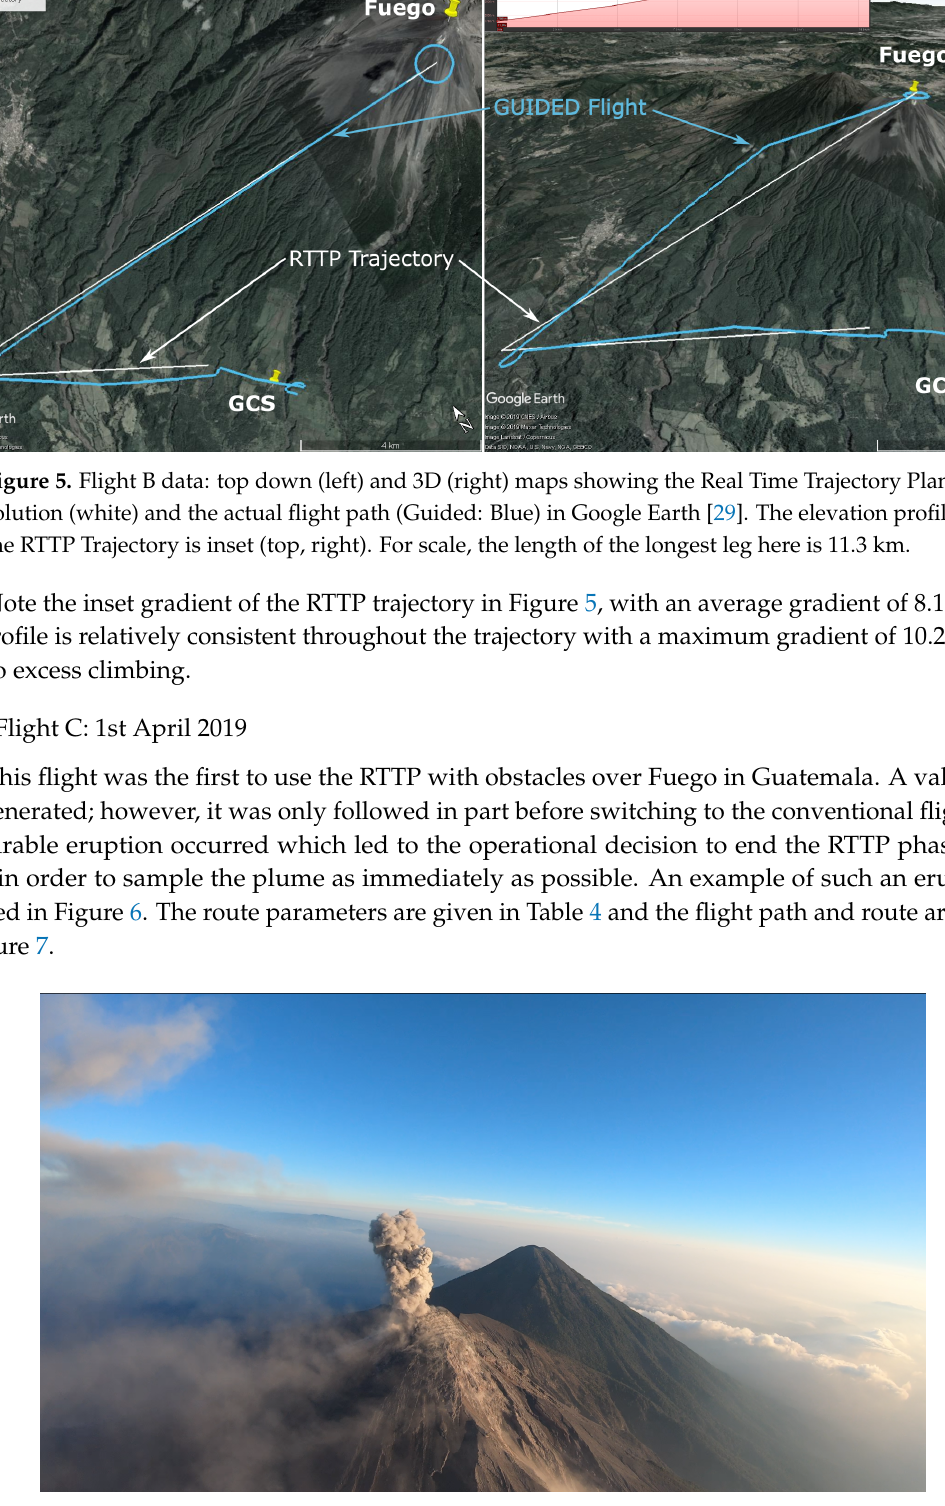
Figure 6. A typical eruption from Fuego (approx 3800 m AMSL) as seen from the on-board camera during an ash-sampling mission. The Ground COntrol Station is at an altitude of 1137 m